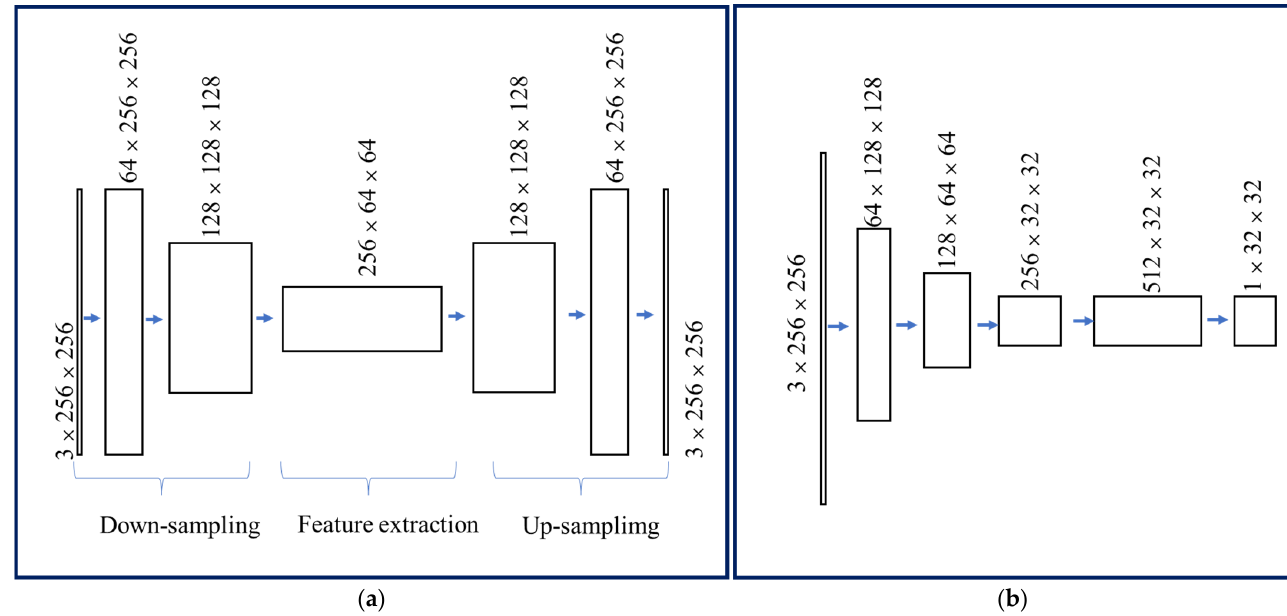
Figure 7. ( a ) Generator structure. ( b ) Discriminator structure.